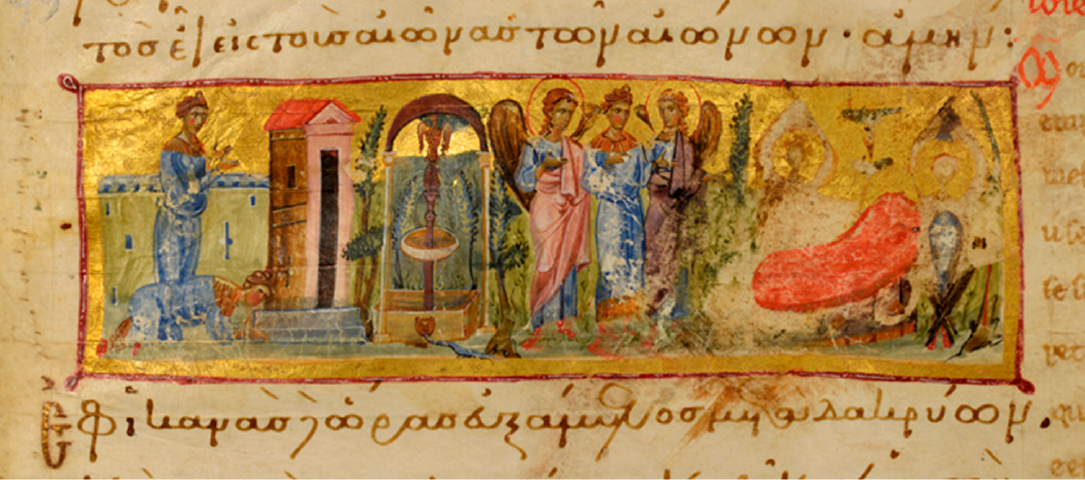
Figure 8. Mount Athos. Holy Iviron Monastery. Athon. Iviron 463, fol. 99r (detail). Ioasaph has a vision of the City of God. Photo: ©Holy Iviron Monastery, Mount Athos, all rights reserved.